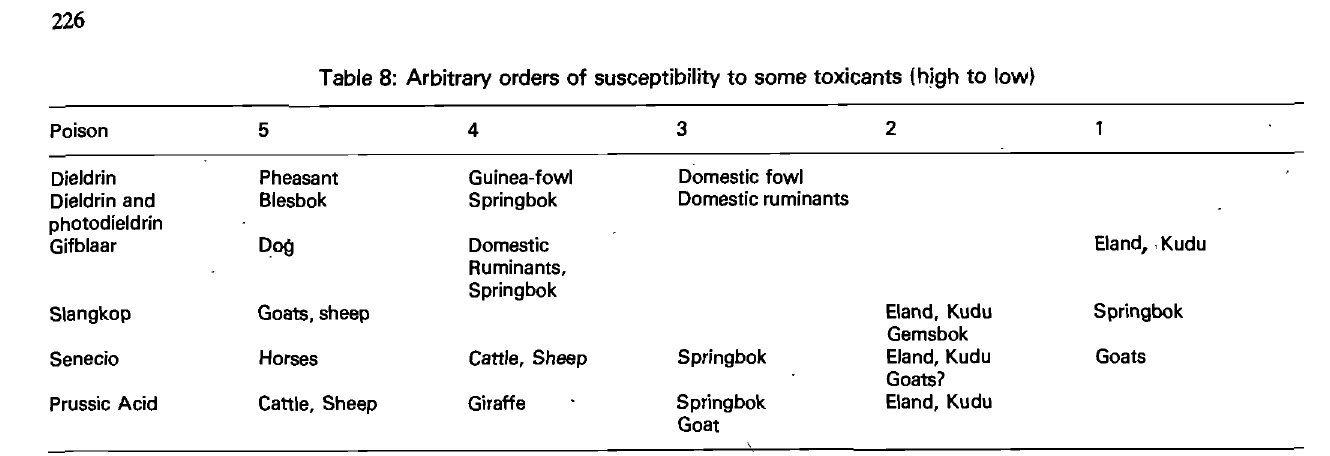
Table 8: Arbitrary orders of susceptibility to some toxicants (high to